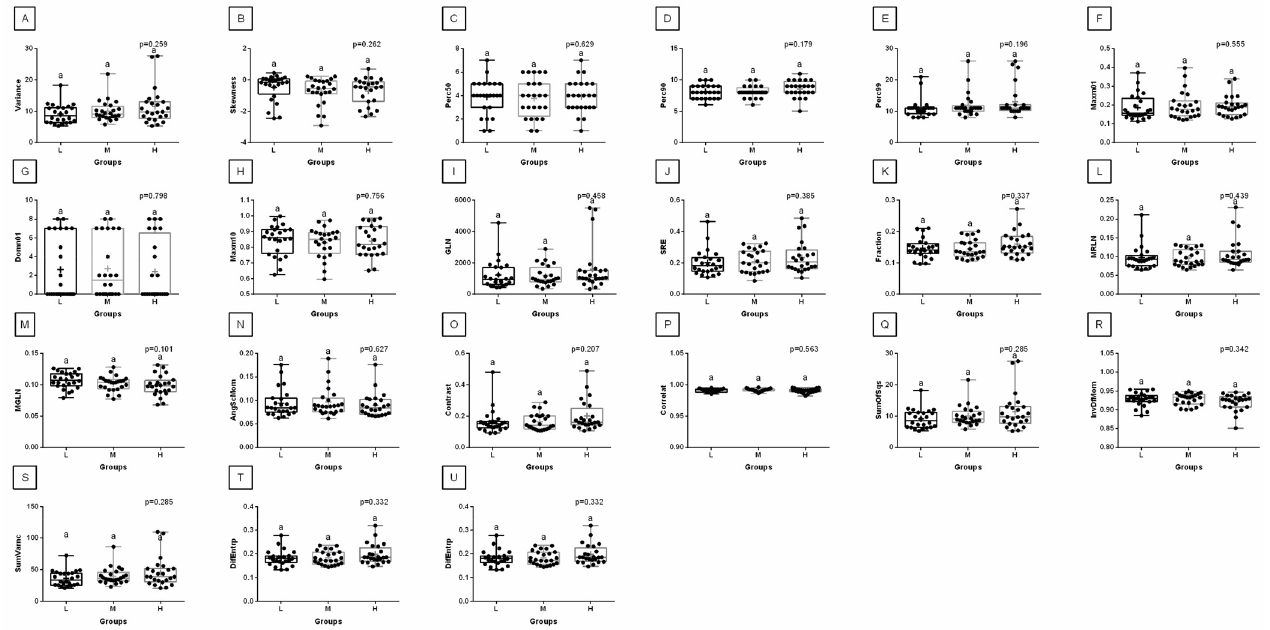
Figure 14. Analysis of texture features for the blue component compared between light (L), mod- erate (M), and heavy (H) groups in the fourth region of interest (ROI 4). Differences between groups were indicated with individual p -values when p < 0.05. Different superscripts on each plot were statistically different. ( A ) Variance; ( B ) Skewness—skewness coefficient; ( C – E ) Perc50, Perc90, Perc99—percentiles; ( F , H ) Maxm01, Maxm10—maximum of moments; ( G ) Domn01— dominant; ( I ) GLN—gray level non-uniformity; ( J ) SRE—short-run emphasis; ( K ) Fraction—a fraction of image in runs; ( L ) MRLN—run-length nonuniformity moment; ( M ) MGLN—gray level non-uniformity moment; ( N ) AngScMom—angular second moment/energy; ( O ) Contrast; ( P ) Correlat—correlation; ( Q ) SumOfSqs—sum of squares; ( R ) InvDefMom—inverse different moment/homogeneity; ( S ) SumVarnc—summation variance; ( T ) DifVarnc—differential variance; ( U ) DifEntrp—differential entropy. Data are presented using minimum and maximum values, lower and upper quartiles, and median. The mean value is marked by a